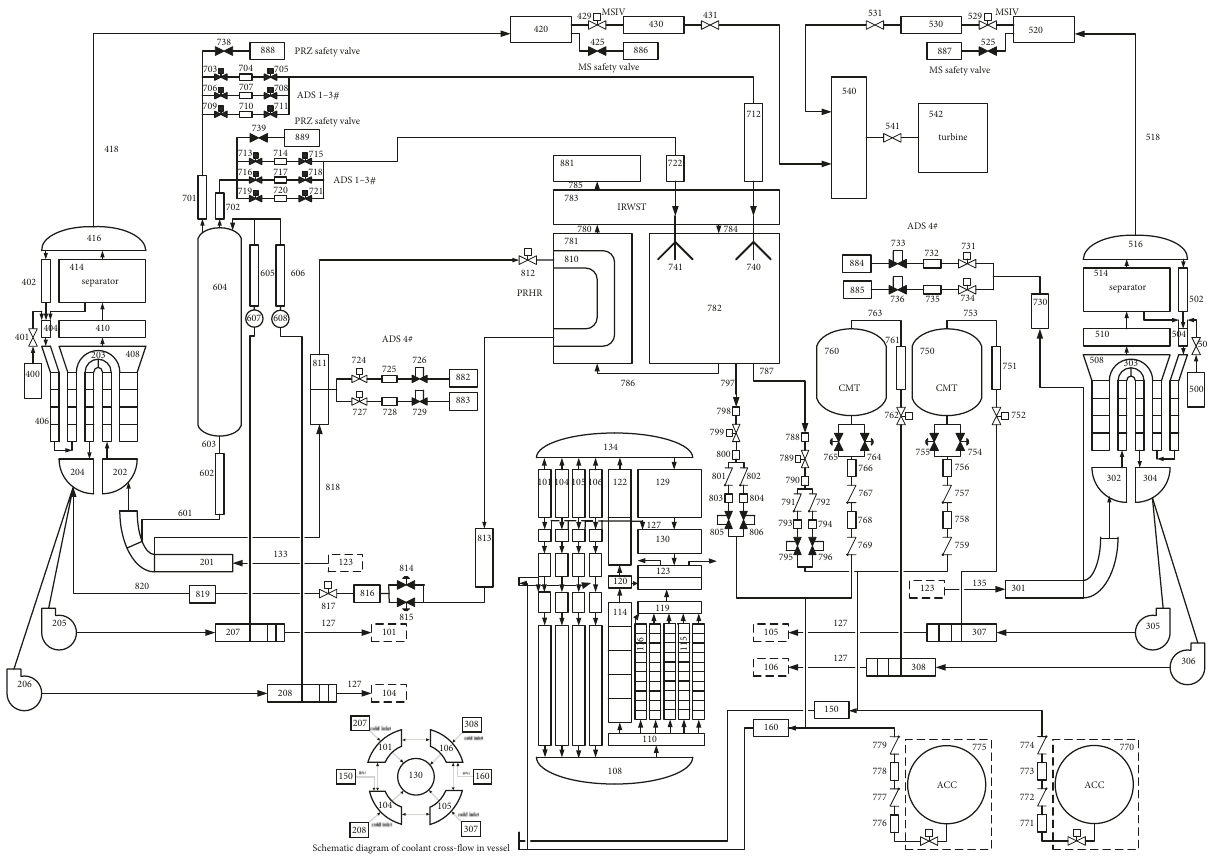
Figure 2: AP1000 RELAP5 model simplified